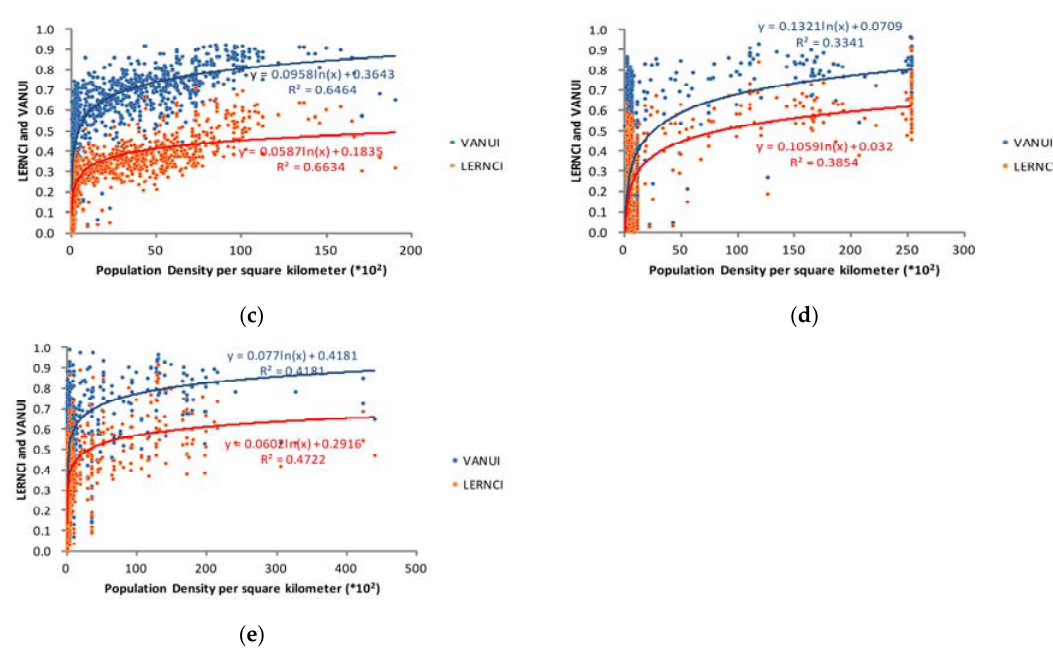
Figure 6. Scatterplots of LERNCI and VANUI against Population Density of ( a ) Beijing ( b ) Lagos ( c ) Tokyo ( d ) New Delhi ( e ) Seoul. The solid lines correspond to the logarithmic regression line.